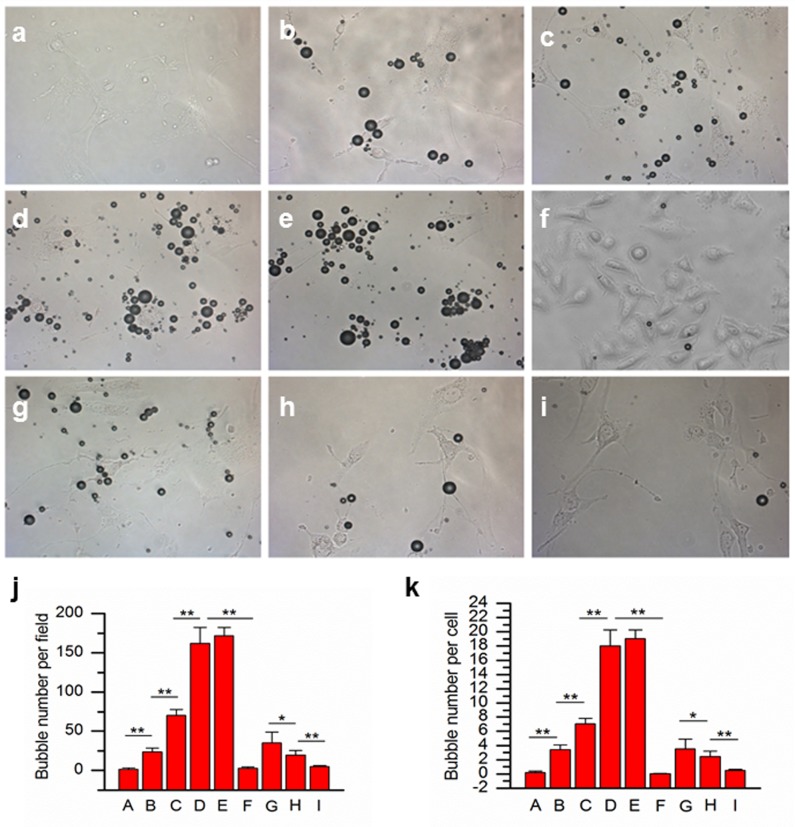
Binding specificity of RGD-MBs.Static binding assay on bEnd.3 cells or αvβ3-negative MCF-7 cells was performed with and without pre incubation with anti-alpha(v) antibodies (×200). (a) Non-targeted control MBs (1×108 particles/mL). (b) 1×106, (c) 1×107, (d) 1×108, and (e) 1×109 particles/mL RGD-MBs. (f) RGD-MBs (1×108 particles/mL) incubated with αvβ3-negative MCF-7 cells. (g-i) RGD-MBs (1×108 particles/mL) with (g)1 ug/ml, (h) 5 ug/ml, and (i) 25 ug/ml anti-alpha(v) antibodies. (j) Quantitative analysis of the number of attached bubbles per field; (k) Quantitative analysis of the number of attached bubbles per cell. (* P < 0.05, ** P < 0.01).